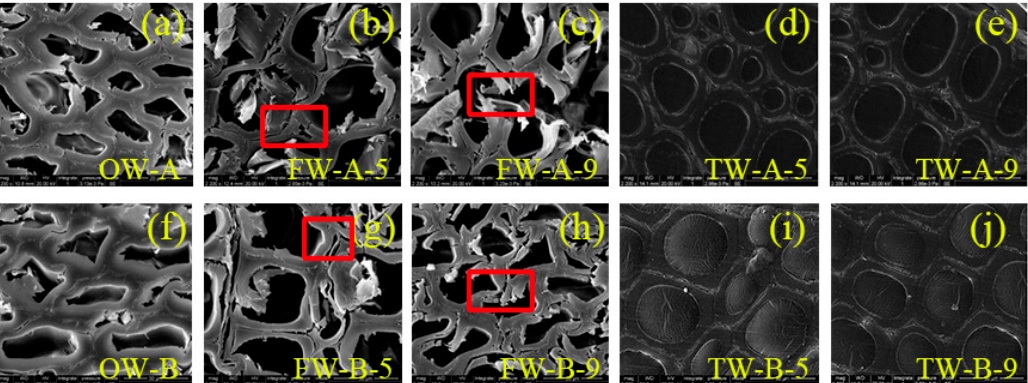
Figure 6. The micro morphology of ( a ) OW-A, ( b ) FW-A-5, ( c ) FW-A-9, ( d ) TW-A-5, ( e ) TW-A-9; ( f ) OW-B, ( g ) FW-B-5, ( h ) FW-B-9, ( i ) TW-B-5, ( j ) TW-B-9.